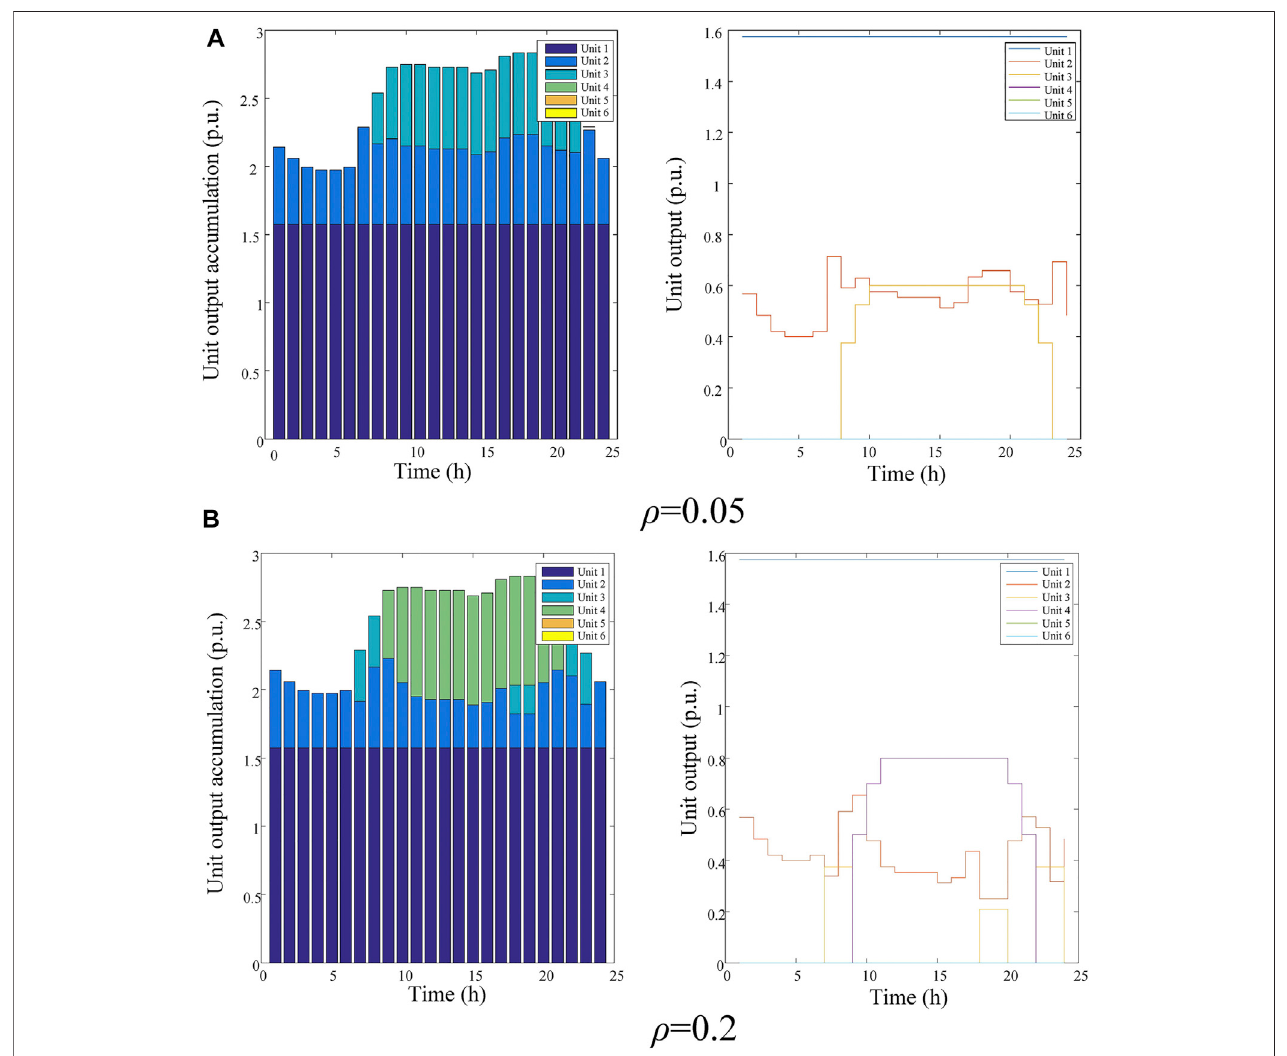
FIGURE 9 | Unit output curves under different hot spare coef fi